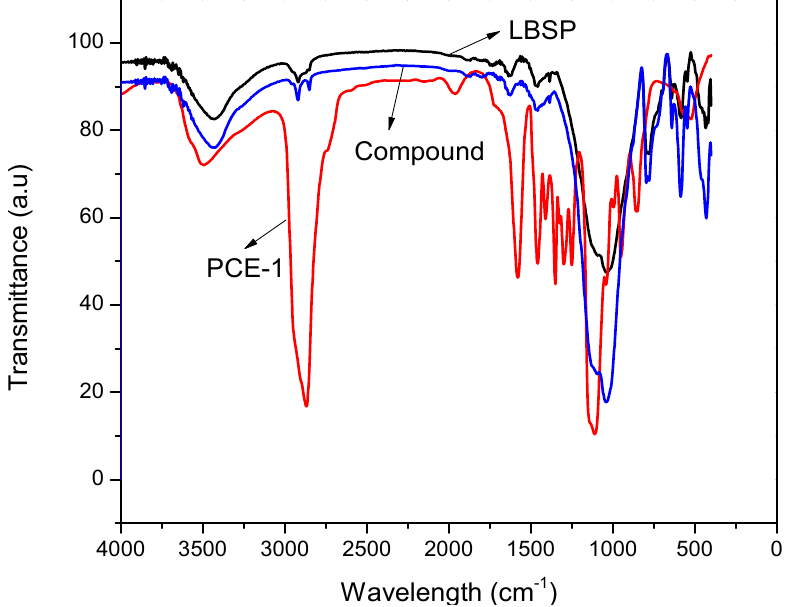
Figure 8. Fourier-transform infrared (FTIR) spectra of PCE-1, LBSP, and the PCE/LBSP compound.